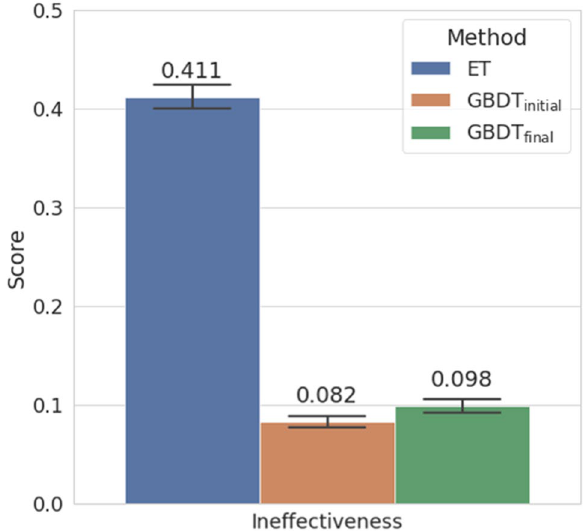
Figure 7. The performance of the prediction models compared with the empirical treatment (ET) regarding ineffectiveness. The initial GBDT model used all predictors and its decision threshold was set to 0.300 here. The final GBDT model used the reduced number of predictors and its decision threshold was set to 0.335. 95% confidence intervals (error bars) were obtained by bootstrap